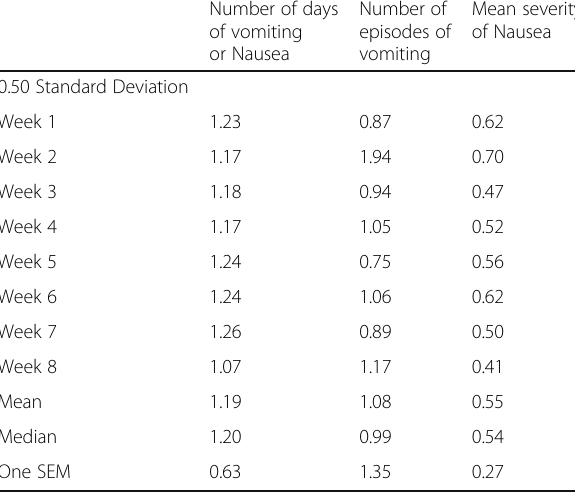
Table 8 Distribution-based definitions of meaningful change for NVSA ©